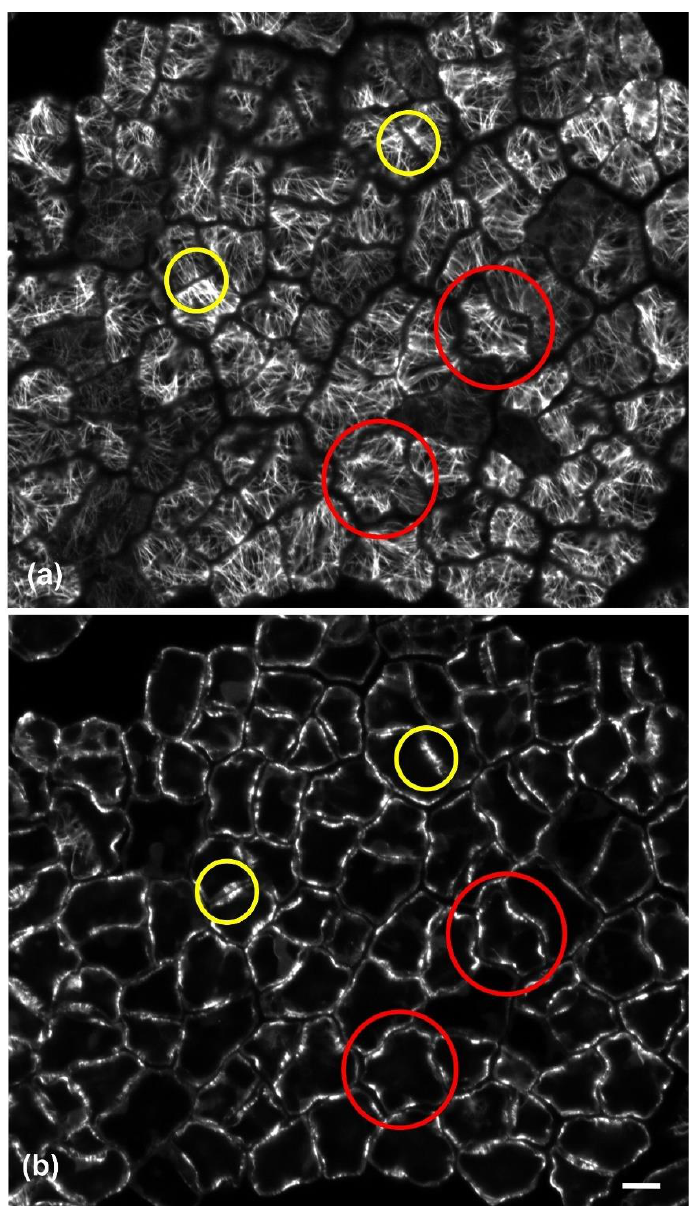
Figure 4. Single CLSM sections depicting microtubule organization in developing cells of the external adaxial leaf epidermal layer after tubulin immunostaining. Radial microtubule arrays extending under the external periclinal wall ( a ) and microtubule bundle profiles at median anticlinal wall height ( b ) can be observed at the same epidermal area. Microtubule arrays with alternating arrangement among adjacent cells are included in red circles, while those with opposite arrangement are included in yellow circles. Scale bars: 10 μm.